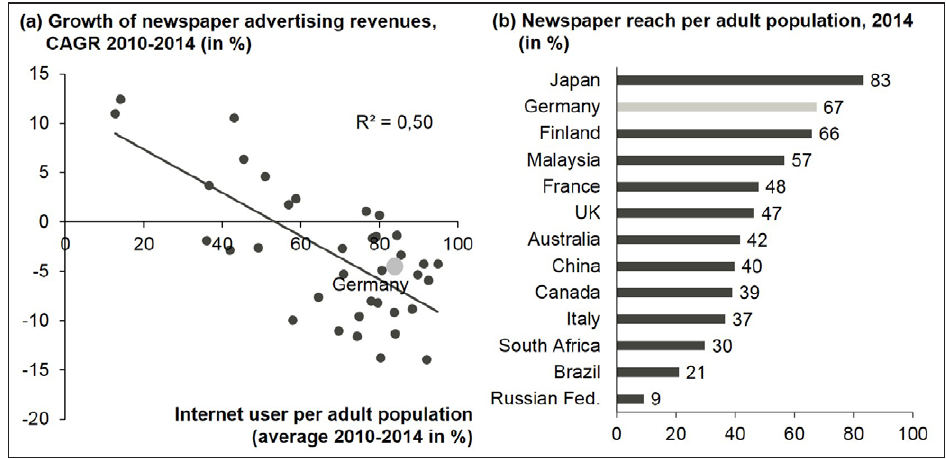
Figure 5: Impact of digital media on advertising and newspaper reach in Germany in international comparison. Source : Own calculations on the basis of raw data from WAN- IFRA